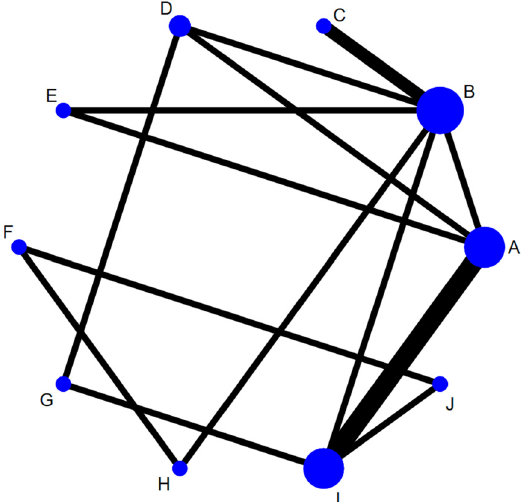
Figure 4: The chemotherapy regimens ’ interaction network of ORR for the 10 chemotherapy regimens ( Every node represented one chemotherapy regimen; the node size represented the sample size of the corresponding chemotherapy regimen; the line thickness between two nodes represented the number of RCT of two chemo - therapy regimens. ) . A = cisplatin + gemcitabine, B = carboplatin